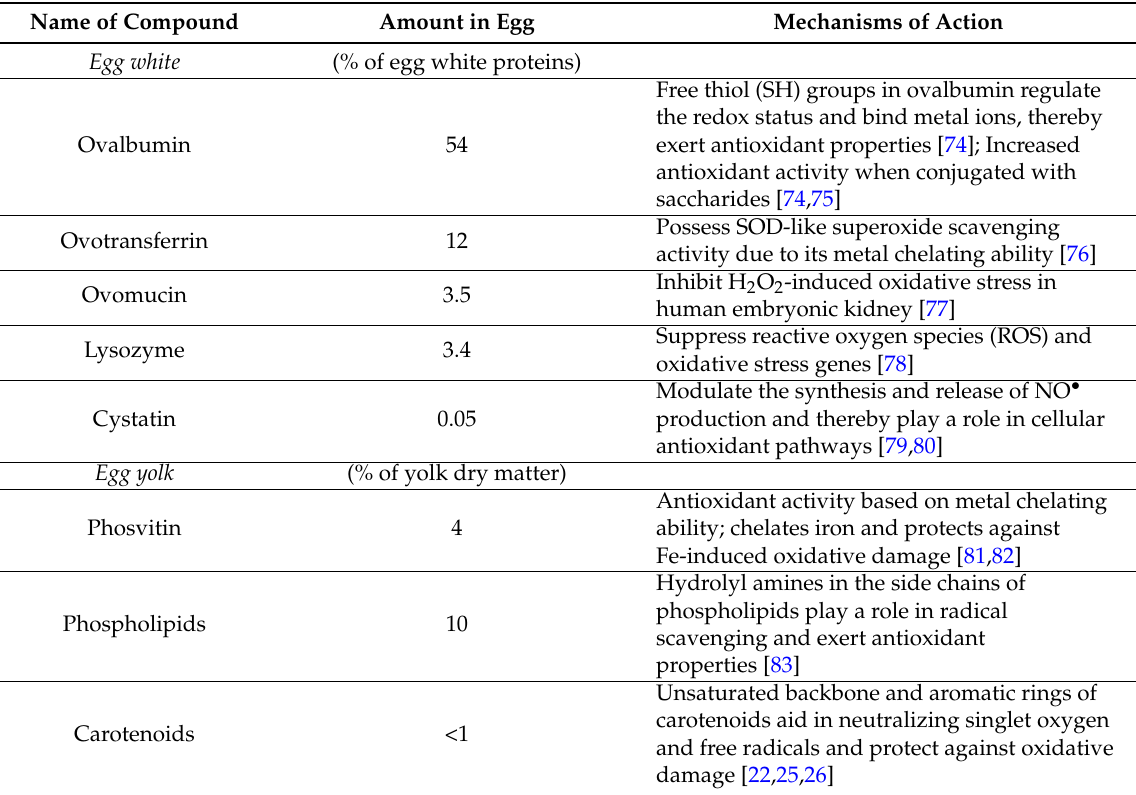
Table 1. Antioxidants in